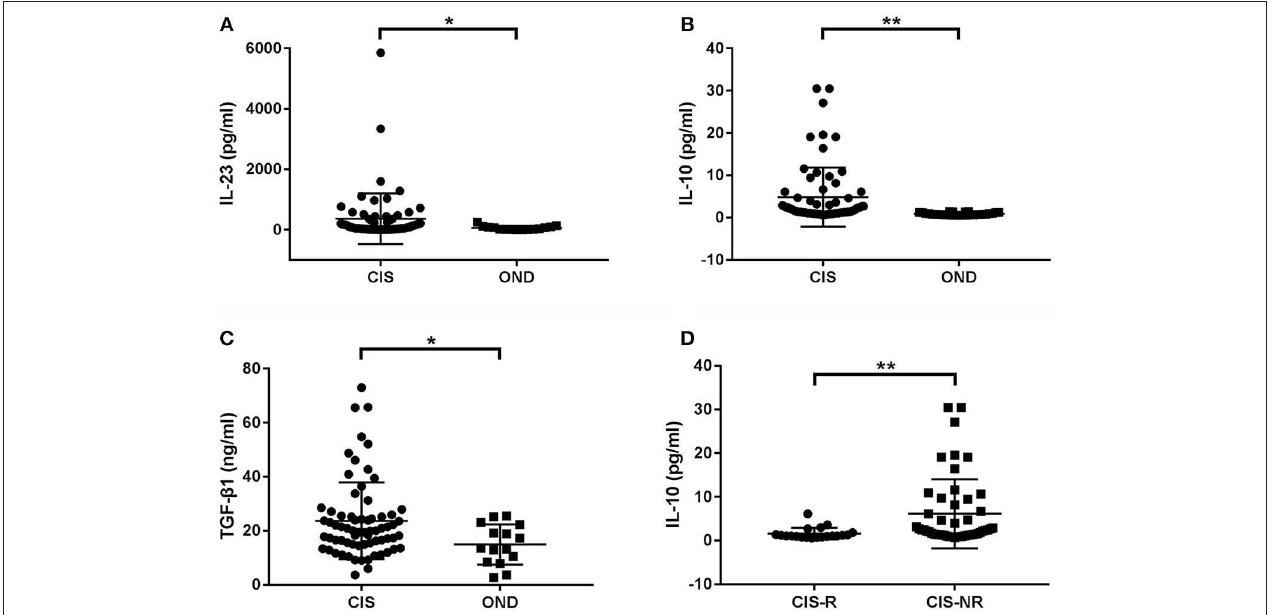
FIGURE 2 | Cytokine levels in serum of patients with clinically isolated syndrome (CIS) and other non-inflammatory neurological diseases (OND). (A) Patients with CIS had significantly higher levels of serum IL-23 than those with OND ( p = 0.015). (B) The serum IL-10 levels in CIS were significantly higher than in OND ( p < 0.001). (C) The serum TGF- β 1 levels in CIS were significantly higher than in OND ( p = 0.022). (D) The serum IL-10 levels in CIS patients who relapsed (CIS-R) were significantly lower than in patients who did not relapse (CIS-NR) during follow-up ( p = 0.001). * p < 0.05 and ** p < 0.01 represent statistical significance using the Mann-Whitney U